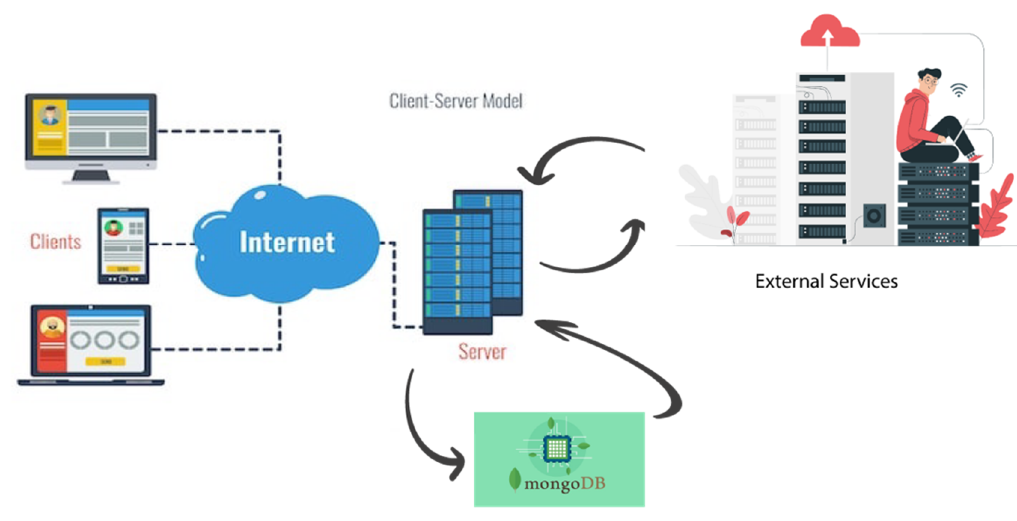
Figure 3. The SAFE Figure 3. The SAFE architecture.